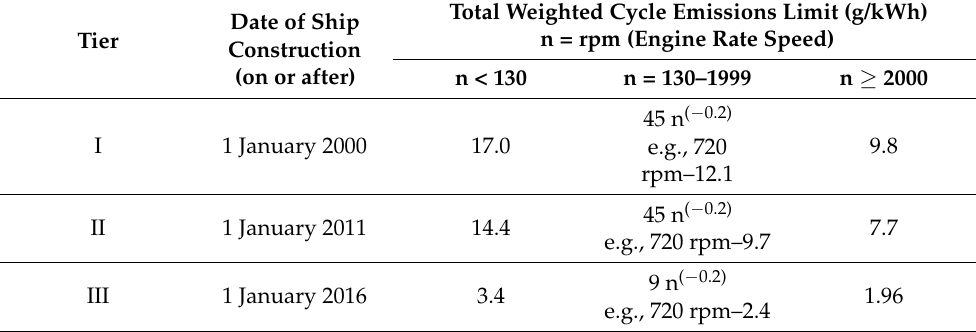
Table 1. NOx emission standards for marine engines.